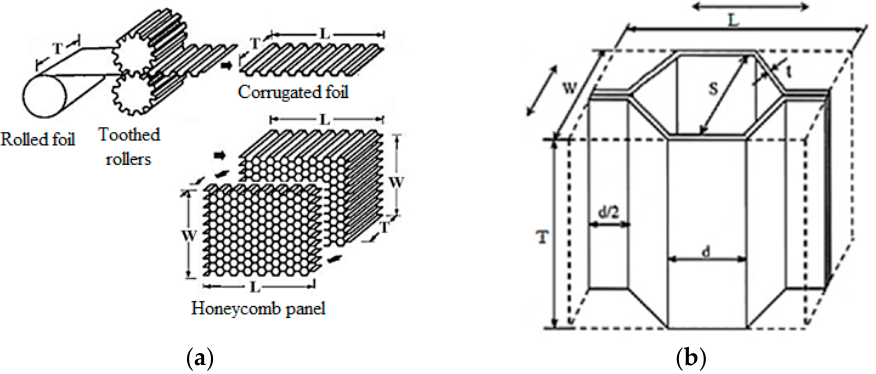
Figure 1. ( a ) Process of aluminum honeycomb development [29]; and ( b ) basic parameters describing structure cell [30].